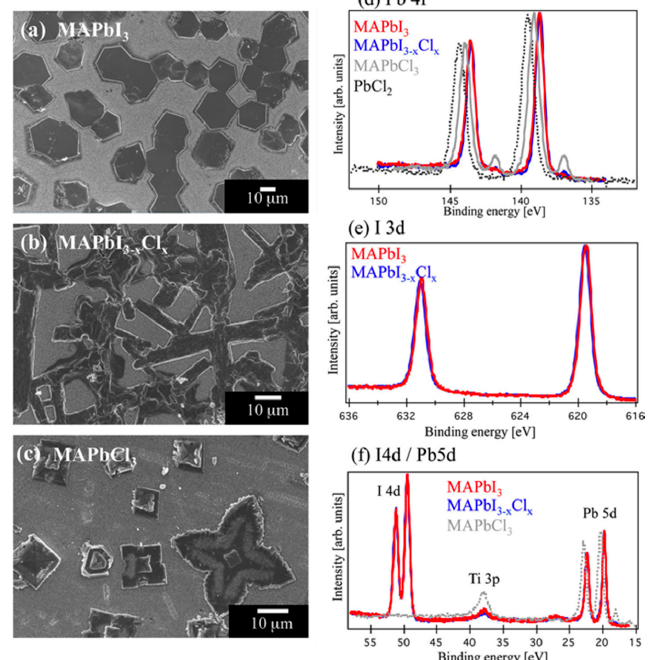
Figure 2. Top-view SEM images of ( a ) the MAPbI 3 (red frame); ( b ) MAPbI 3 − x Cl x (blue frame); and ( c ) MAPbCl 3 (gray frame) materials deposited on a TiO 2 /FTO substrate. (Horizontal scale bars = 10 mm.) Also shown are ( d ) Pb 4f spectra; ( e ) I 3d spectra; and ( f ) Pb 5d/I 4d spectra of MAPbI 3 (red solid line), MAPbI 3 − x Cl x (blue solid line), and MAPbCl 3 (light gray line) recorded with an excitation energy of 4000 eV [41]. Copyright © 2015, American Chemical Society, Washington, DC, USA.